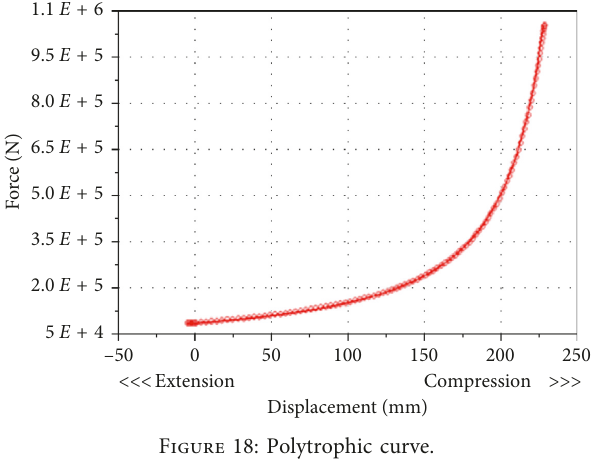
Figure 18: Polytrophic curve.